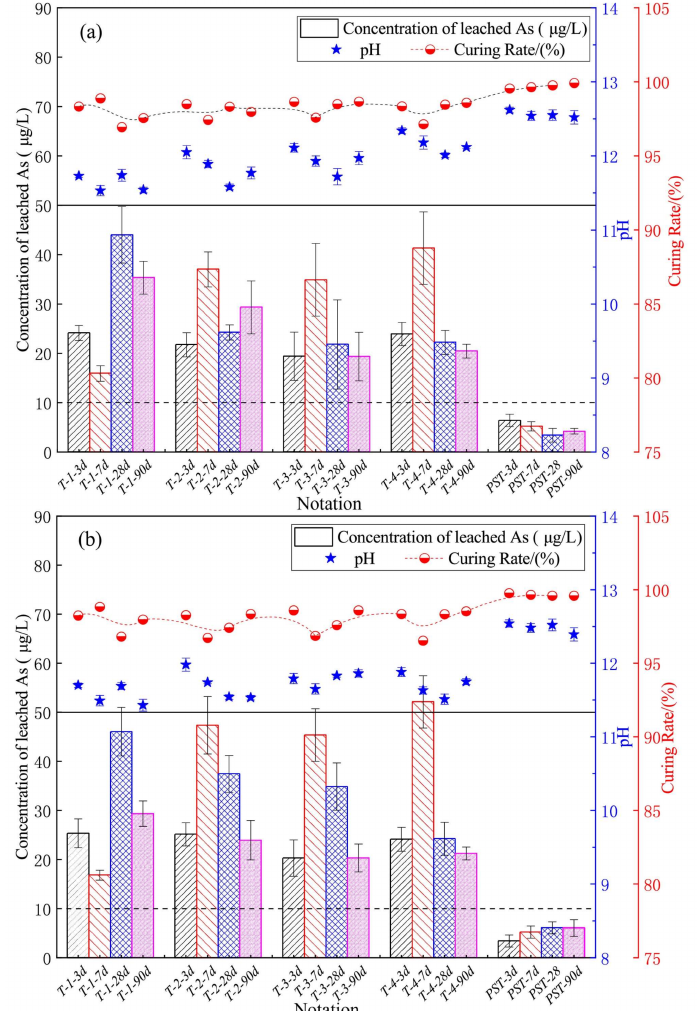
Figure 2. Concentration of leached As, leachate pH, and As curing rate of ( a ) the horizontal vibration method tests; ( b ) the sulfuric acid and nitric acid method